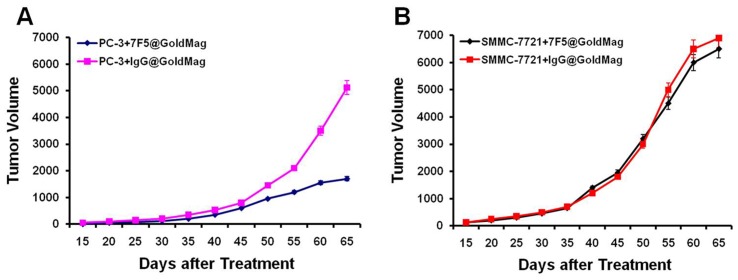
Evaluation of immunotherapeutic efficacy.For PC-3 mice, tumor volumes were significantly smaller for 7F5@Au/Fe3O4 treated animals (p<0.05) compared to those mice with IgG@Au/Fe3O4 control probe (A). No significant difference in tumor volume progression was observed for SMMC-7721 mice following injection of either 7F5@Au/Fe3O4 or IgG@Au/Fe3O4 probes (B).